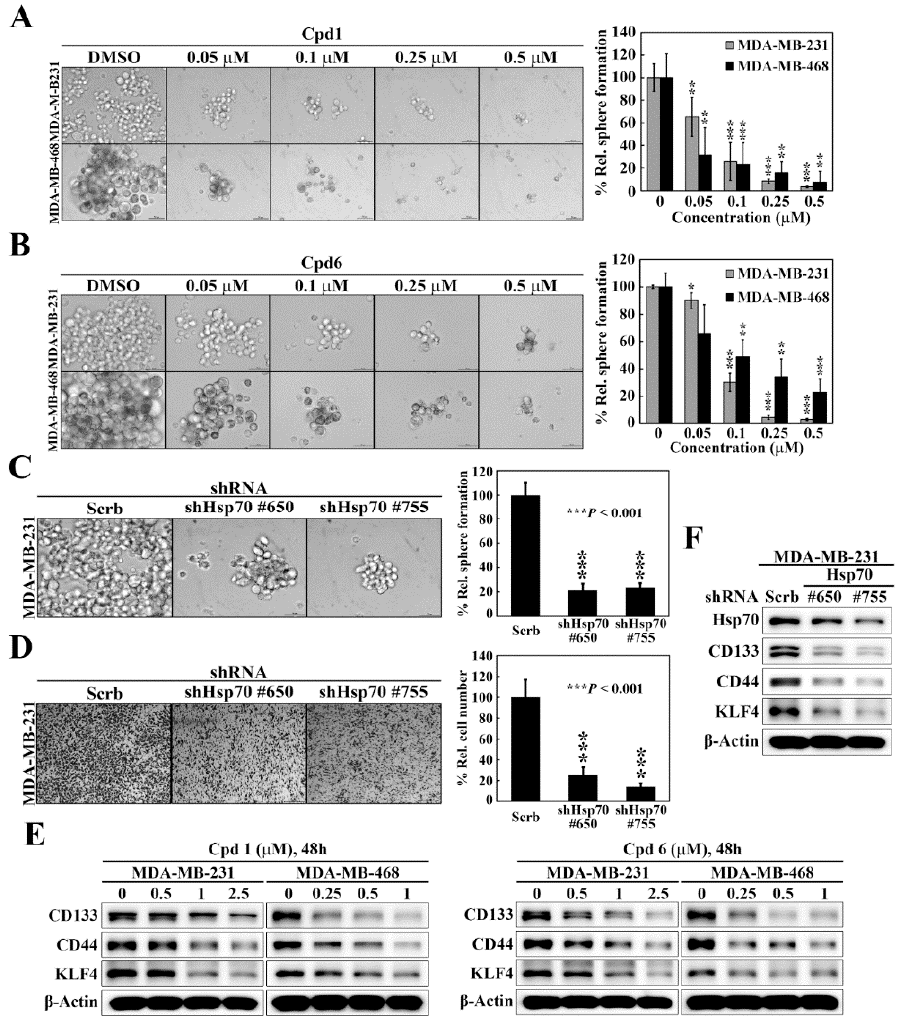
Figure 4. Hsp70 is involved in maintaining cancer stem cells in triple negative breast cancer